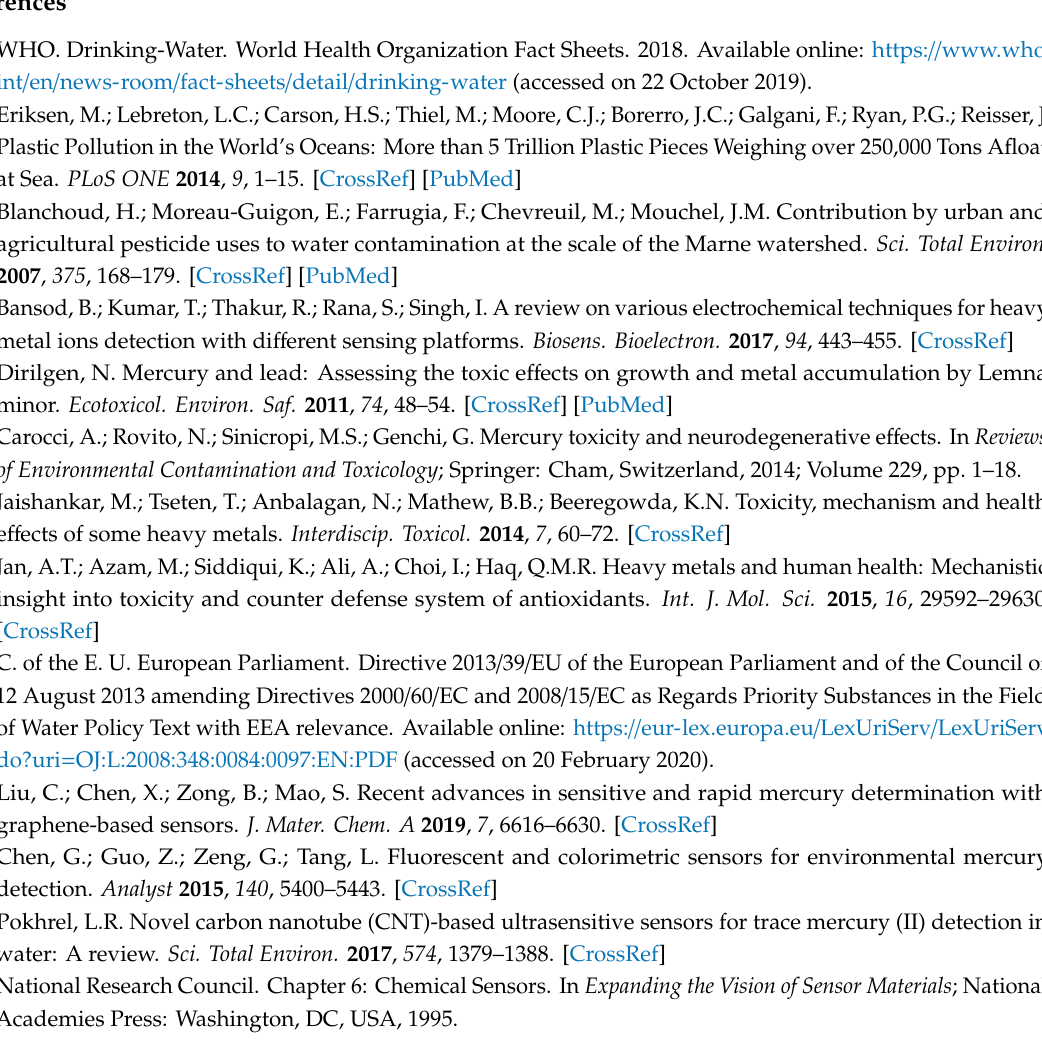
Table S1: Measurement of the pH values and refractive indices of the Hg 2 + solutions in PBS; Table S2: Measurement of the pH values and refractive indices of the Hg 2 + solutions in ultrapure water; Table S3: Measurement of the pH values and refractive indices of the Hg 2 + solutions in tap